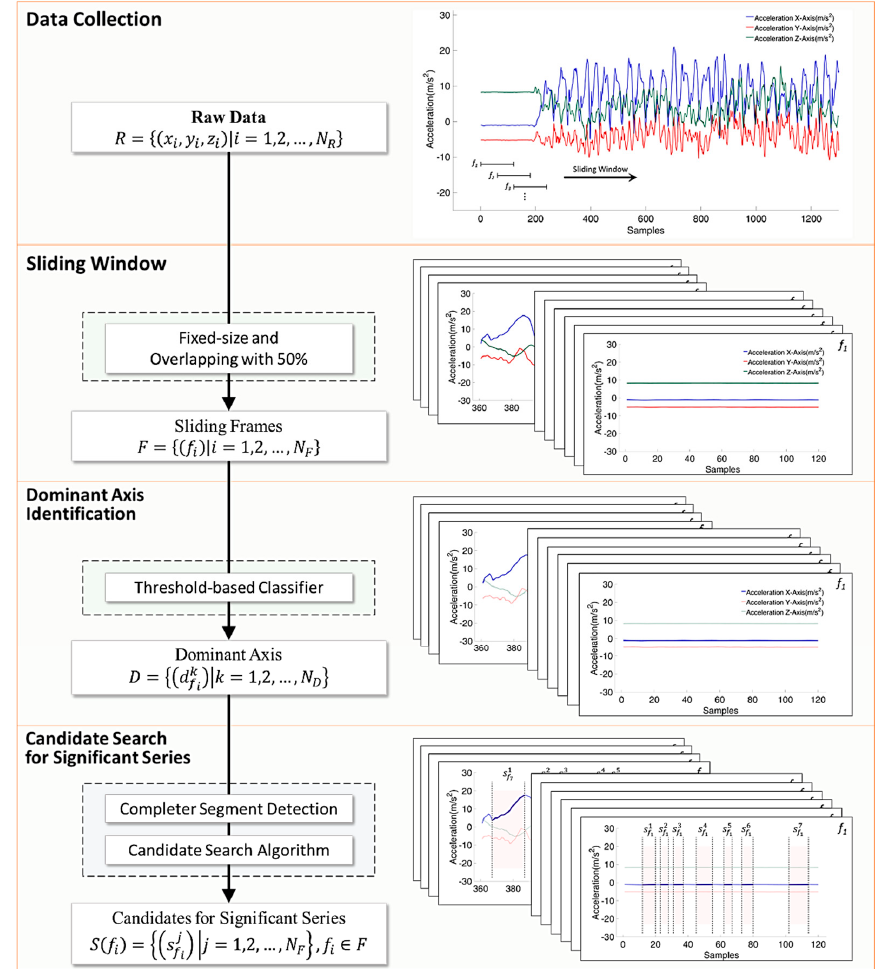
Figure 2. Framework of the hierarchical candidate search for significant change from raw data.